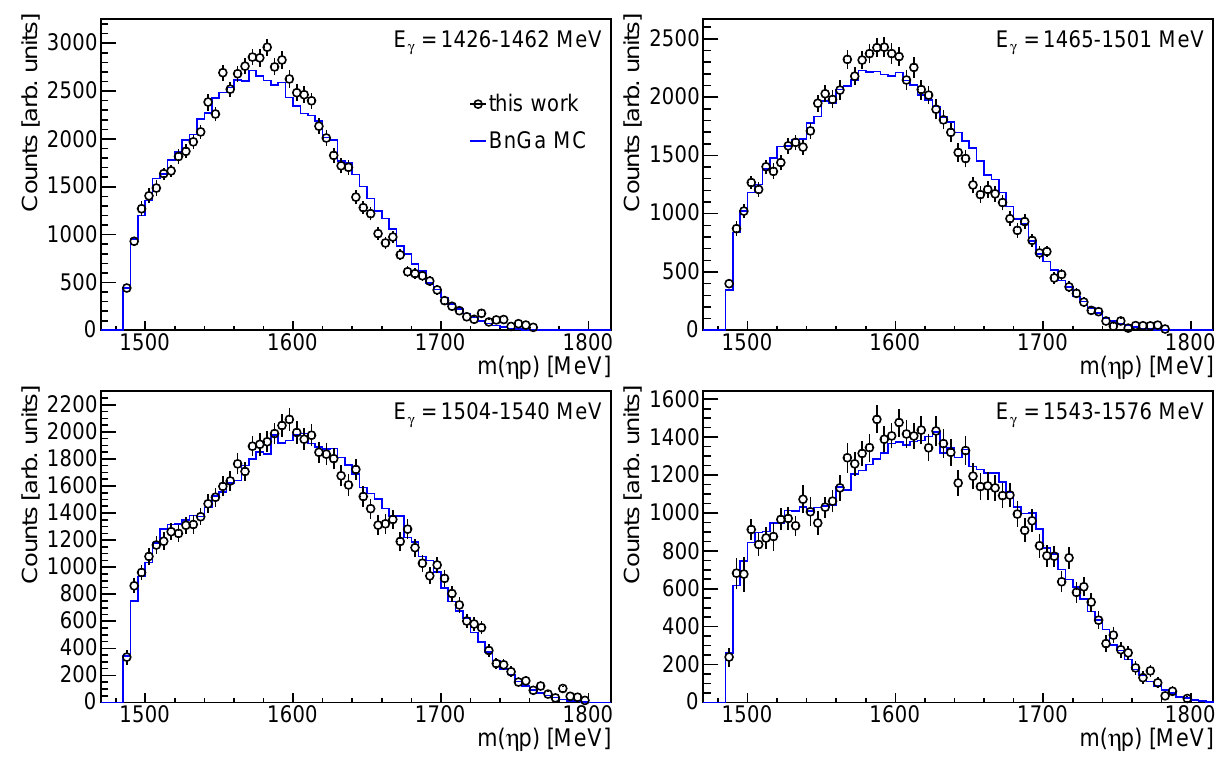
Figure 5. Invariant mass m ( η p ) of γ p → ηπ 0 p for four bins of photon-beam energy (no acceptance correction). The data (black circles) are compared to a phase-space MC simulation (blue curves, normalized by integral ratio) using event weights from the BnGa partial-wave analysis of [45].